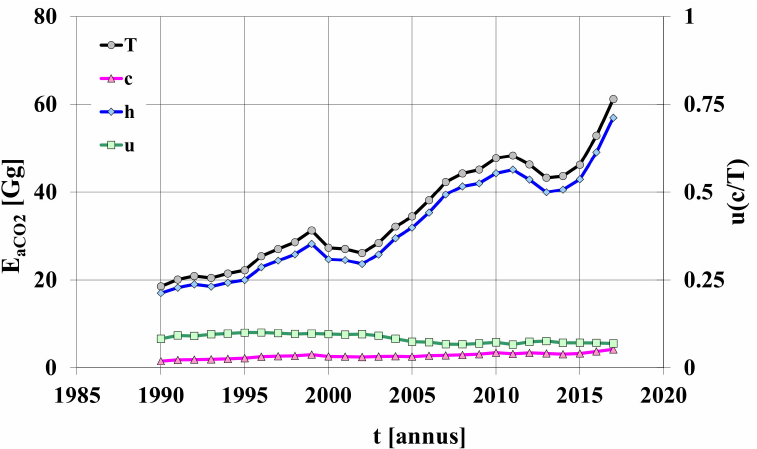
Figure 5. Annual emission of carbon dioxide—E aCO2 : national (total)—T, from car engines at cold- start—c, from car engines at warm-up—h and the share of additional emissions during engine heating in total emissions—u(c/T).